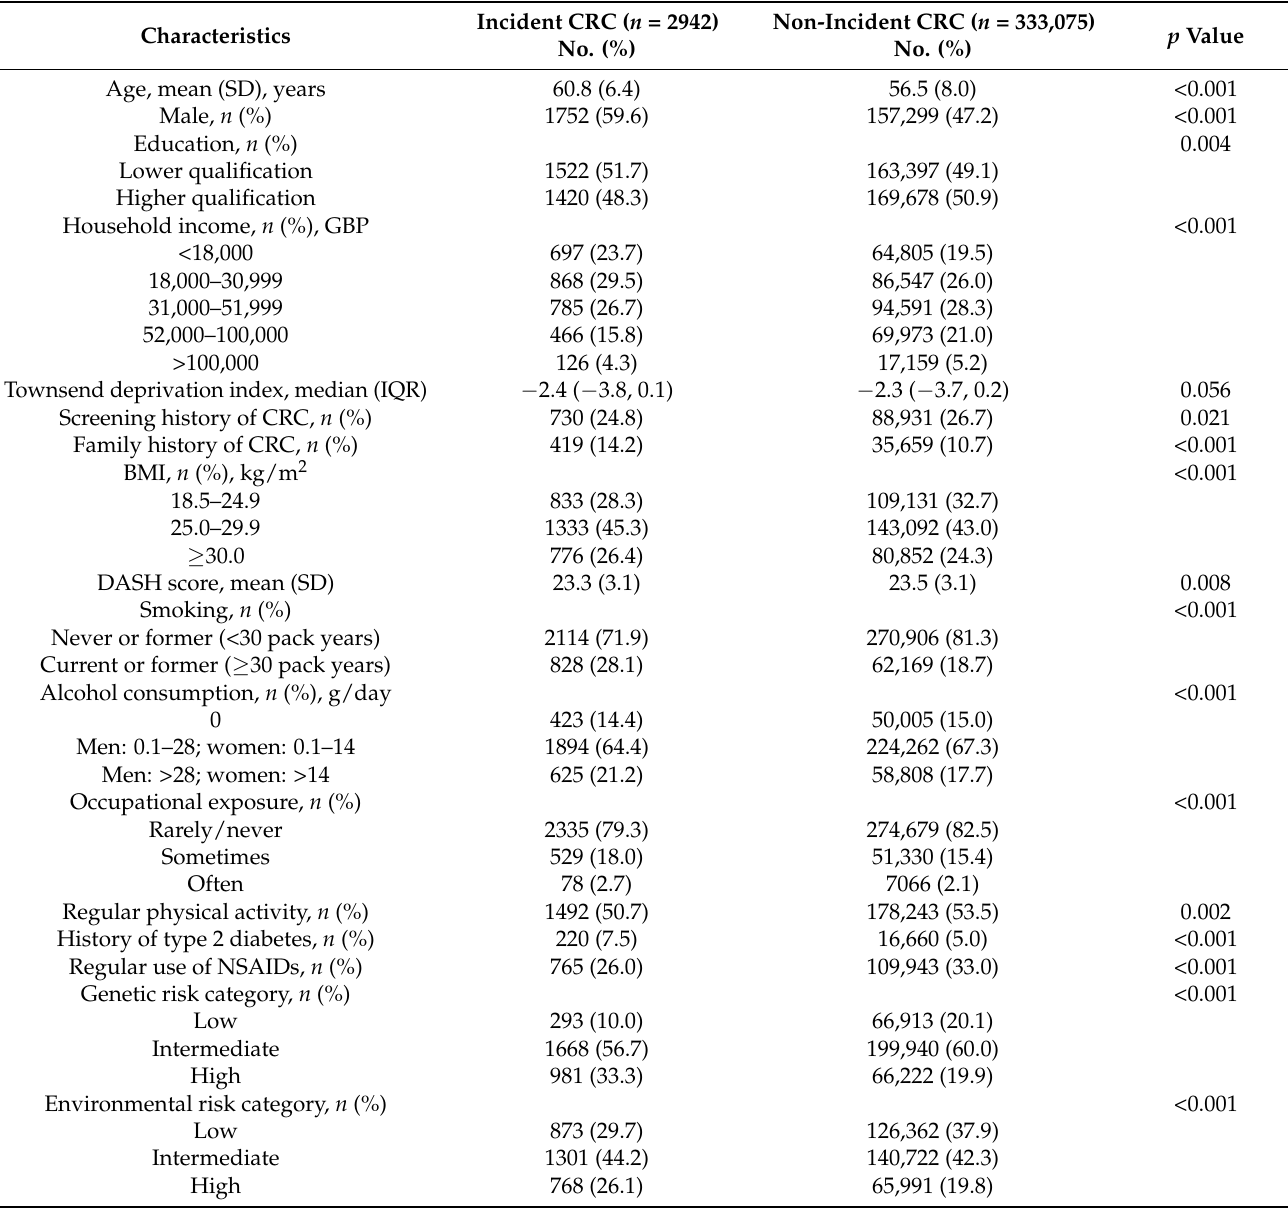
Table 1. Comparison of characteristics of participants with and without CRC a